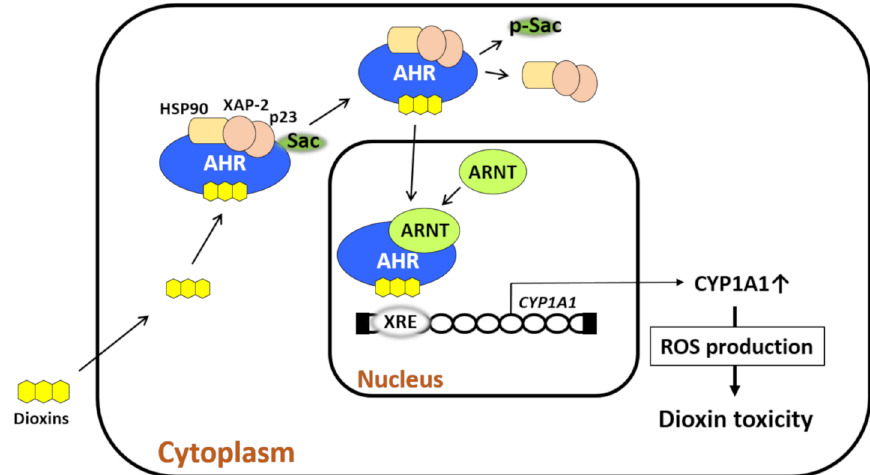
Figure 1. Dioxin-mediated activation of aryl hydrocarbon receptor (AHR) induces oxidative stress. AHR resides in the cytoplasm with chaperone proteins (heat shock protein 90 [HSP90], X-associated protein 2 [XAP-2], and p23) and c-Src. Upon ligation by dioxin, AHR leaves this chaperone complex upon c-Src phosphorylation. AHR then translocates from the cytoplasm to the nucleus, in which the dioxin–AHR complex couples with AHR nuclear translocator (ARNT). The dioxin–AHR–ARNT complex binds the xenobiotic response elements (XREs) of target genes such as cytochrome P450 1A1 (CYP1A1), CYP1A2, and CYP1B1. CYP1A1 metabolizes the ligand and induces reactive oxygen species (ROS) generation during the metabolic process. Dioxins are chemically stable and tolerant to CYP1A1 activity, and thus, they induce high levels of ROS production. Dioxin-induced oxidative stress characterizes dioxin-mediated